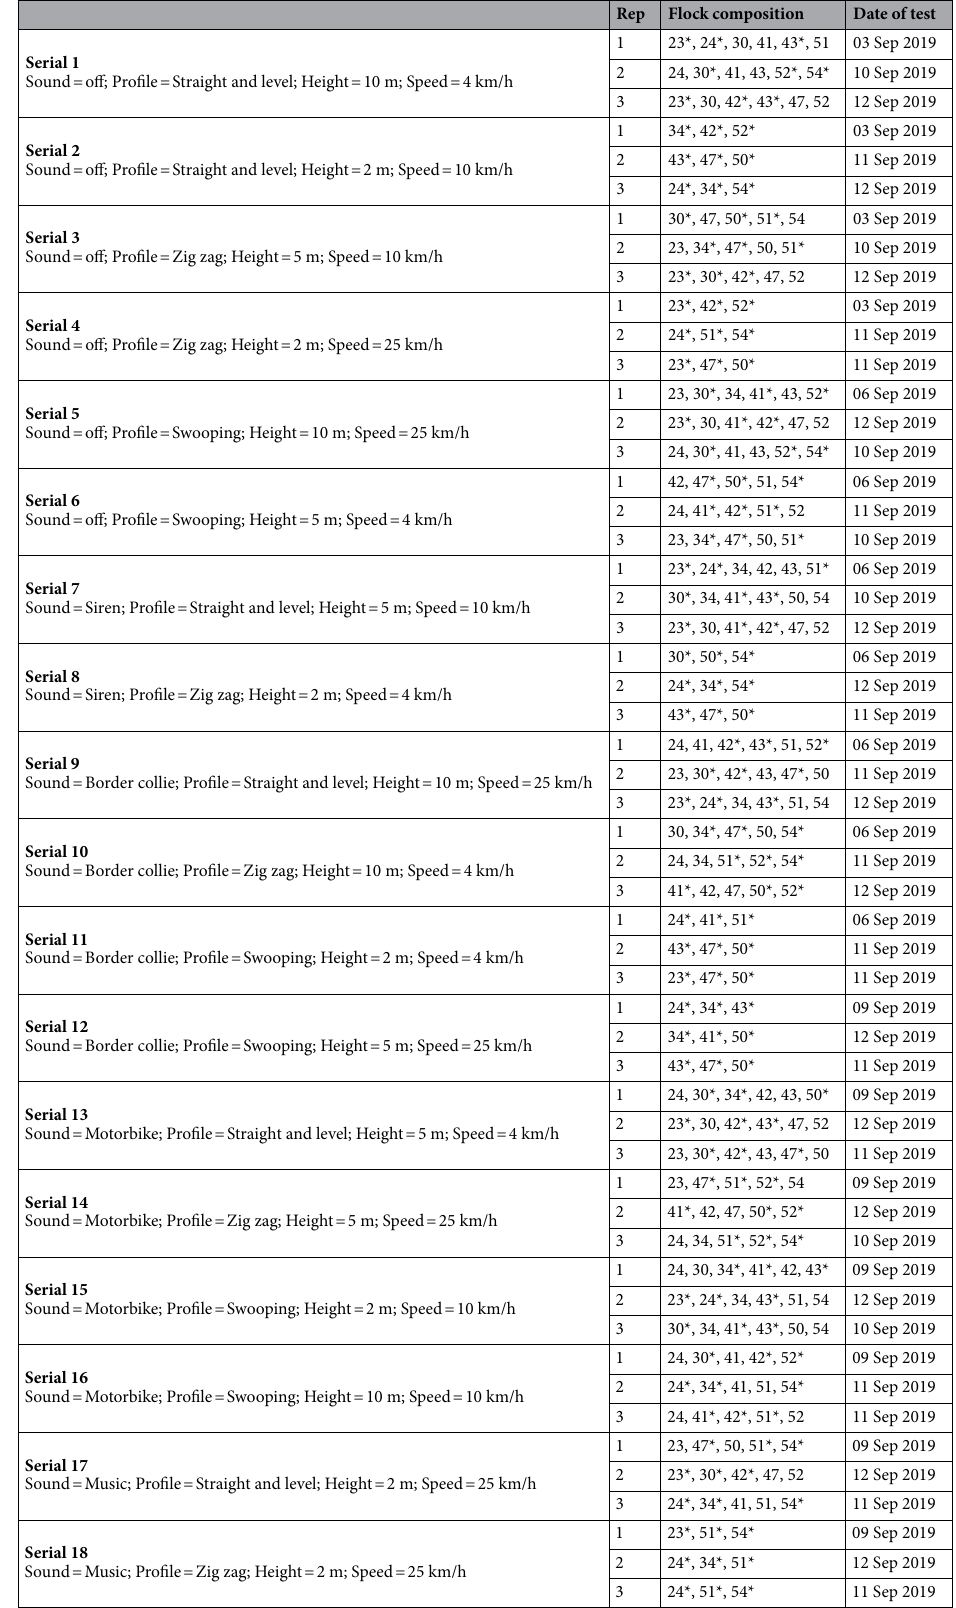
Table 1. Test design and conduct. *Indicates Zephyr Bioharness